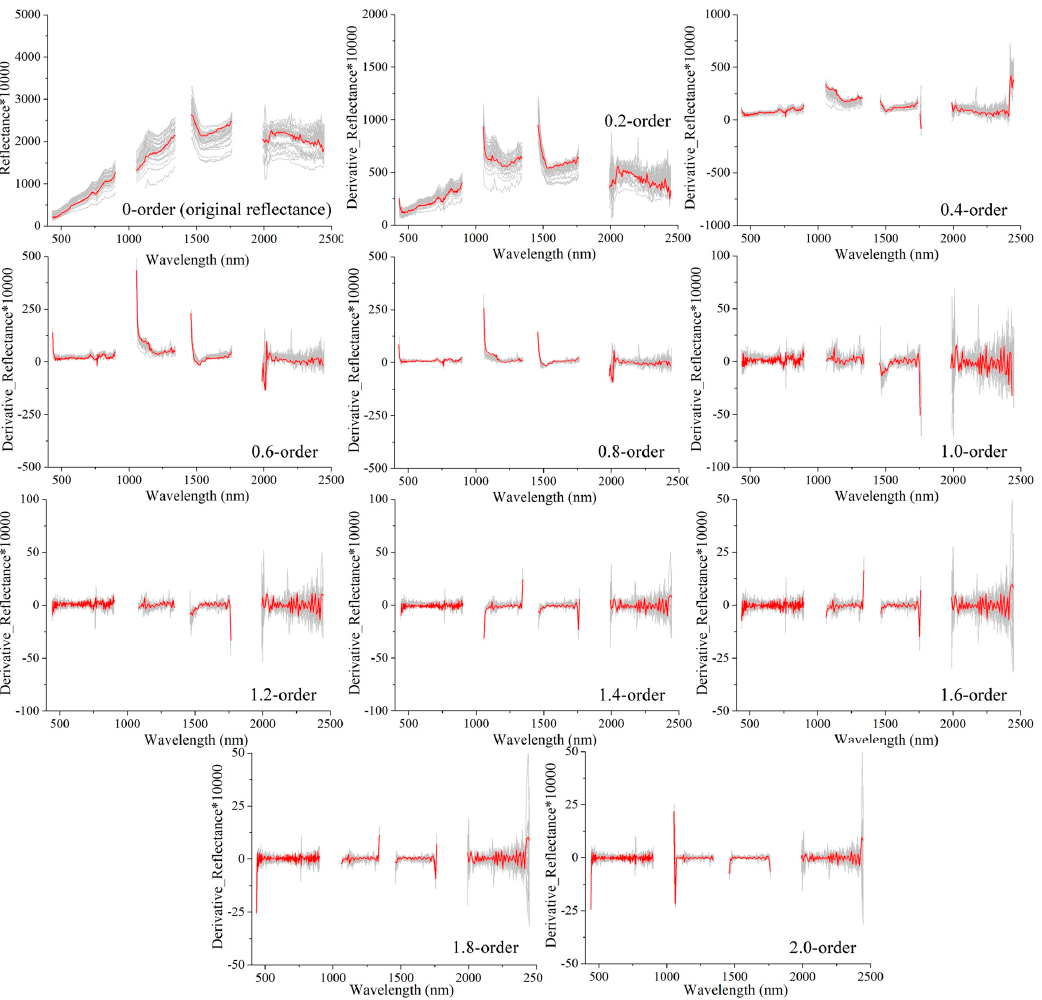
Figure 7. Varying spectral curves of the whole dataset under different FODs (0 to 2, increment of 0.2). The red curve represents the average spectral curve of the whole dataset.